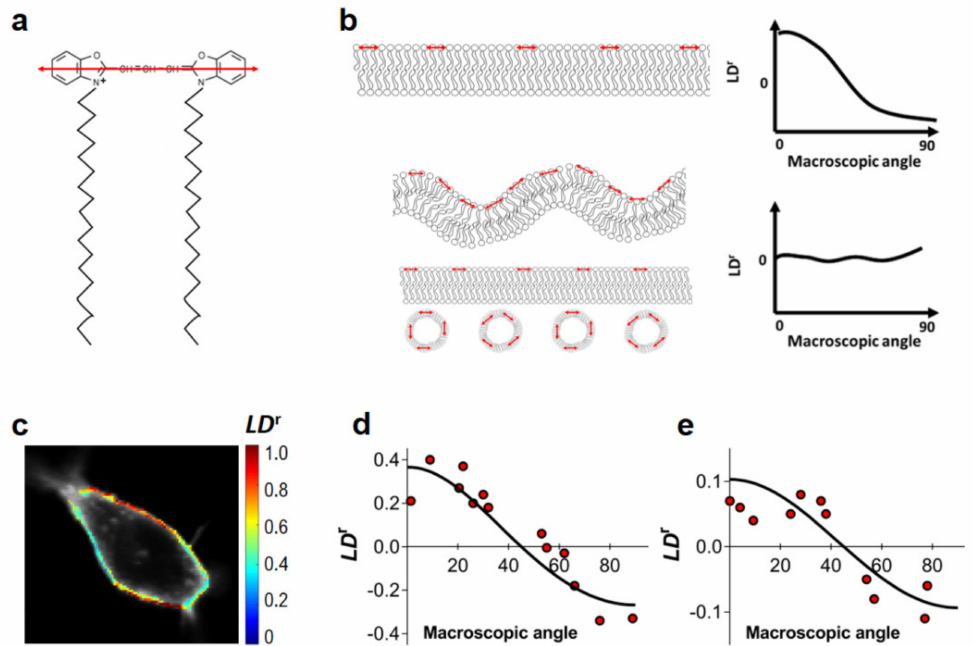
Figure 1. Evaluation of nanoscale ruffling of the plasma membrane. Reduced linear dichroism ( LD r ) values of the DiOC18(3) membrane probe in HEK293T and HeLa cells. ( a ) Structure of DiOC18(3). The orientation of the fluorophore’s absorption dipole is shown in red. ( b ) Schematic representation of the impact of different membrane topologies on the recovered LD r values of DiOC18(3) when using a polarized excitation source. A planar membrane (top) implies the presence of heavily aligned fluorophores, such that the probability of excitation depends heavily on membrane orientation. In the case of non-flat membranes or in the presence of intracellular vesicles in the immediate vicinity of the plasma membrane (bottom), the orientation of the absorption dipoles of DiOC18(3) is no longer homogeneous and no dependence of LD r on macroscopic membrane orientation is expected. Red arrows indicate the orientation of the transition dipole of DiOC18(3). ( c ) LD r imaging of DiOC18(3) in a HEK293T cell (false color scale). LD r values relative to membrane orientation are shown for HEK293T ( d ) and HeLa ( e ) cells. LD r values were determined as described in Section 2 of the Supplementary Materials. Each data point corresponds to ROI in the plasma membrane of a given